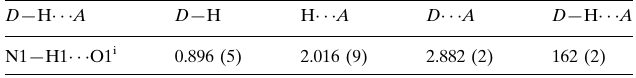
Hydrogen-bond geometry (A˚ , (cid:2)